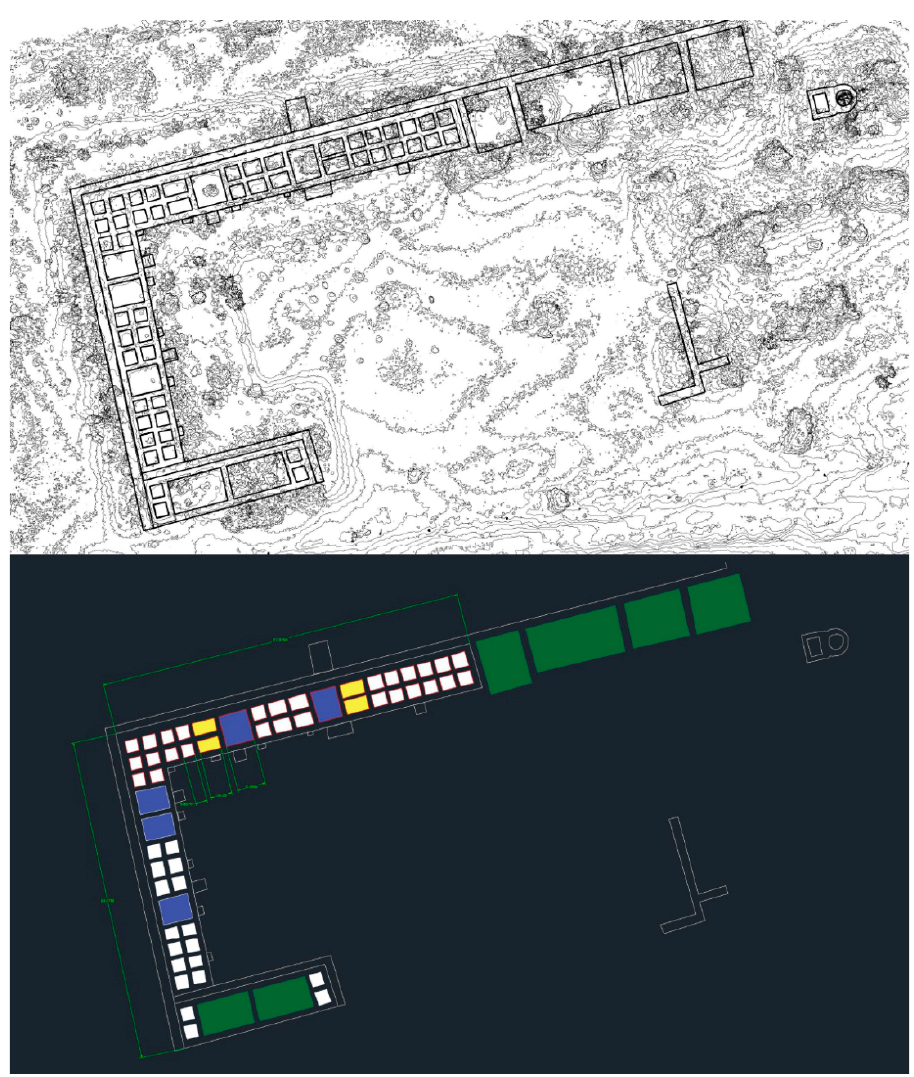
Figure 11. Two examples of designs produced from the digital model. Top Image: design of facilities based on photogrammetry; Bottom Image: classification of production areas based on photogrammetry.